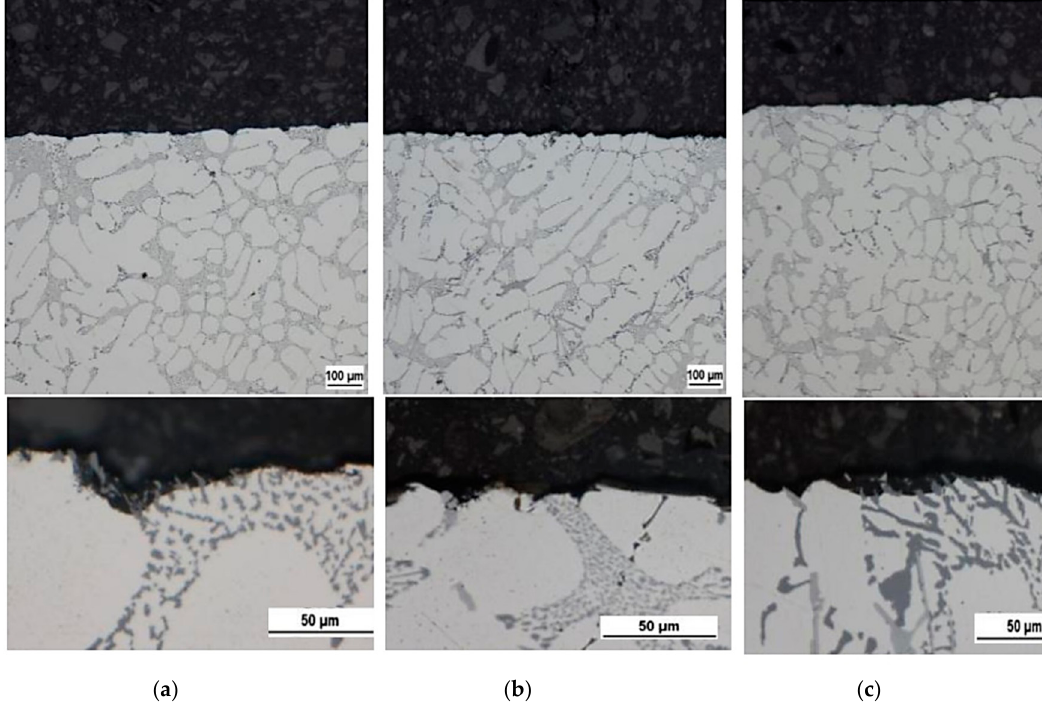
Figure 7. Corrosion attack of AlSi7Mg0.3 cast alloys, etch. MA. ( a ) alloy A with 0.123% Fe; ( b ) alloy B with 0.454% Fe; ( c ) alloy C with 0.655% Fe.